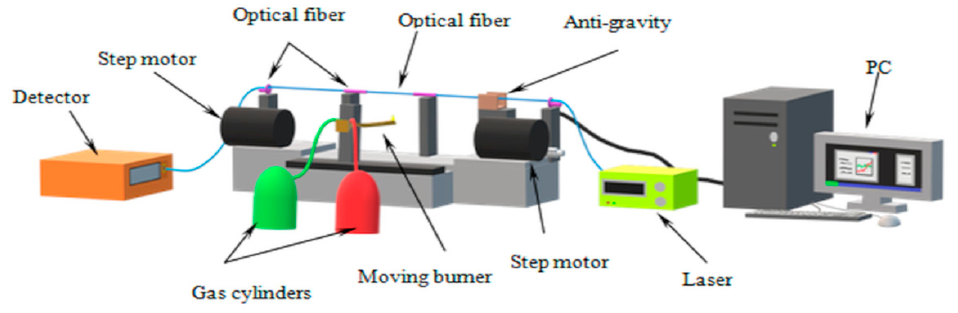
Figure 4. Schematic of FOTET system for biconical optical fiber manufacturing [34].